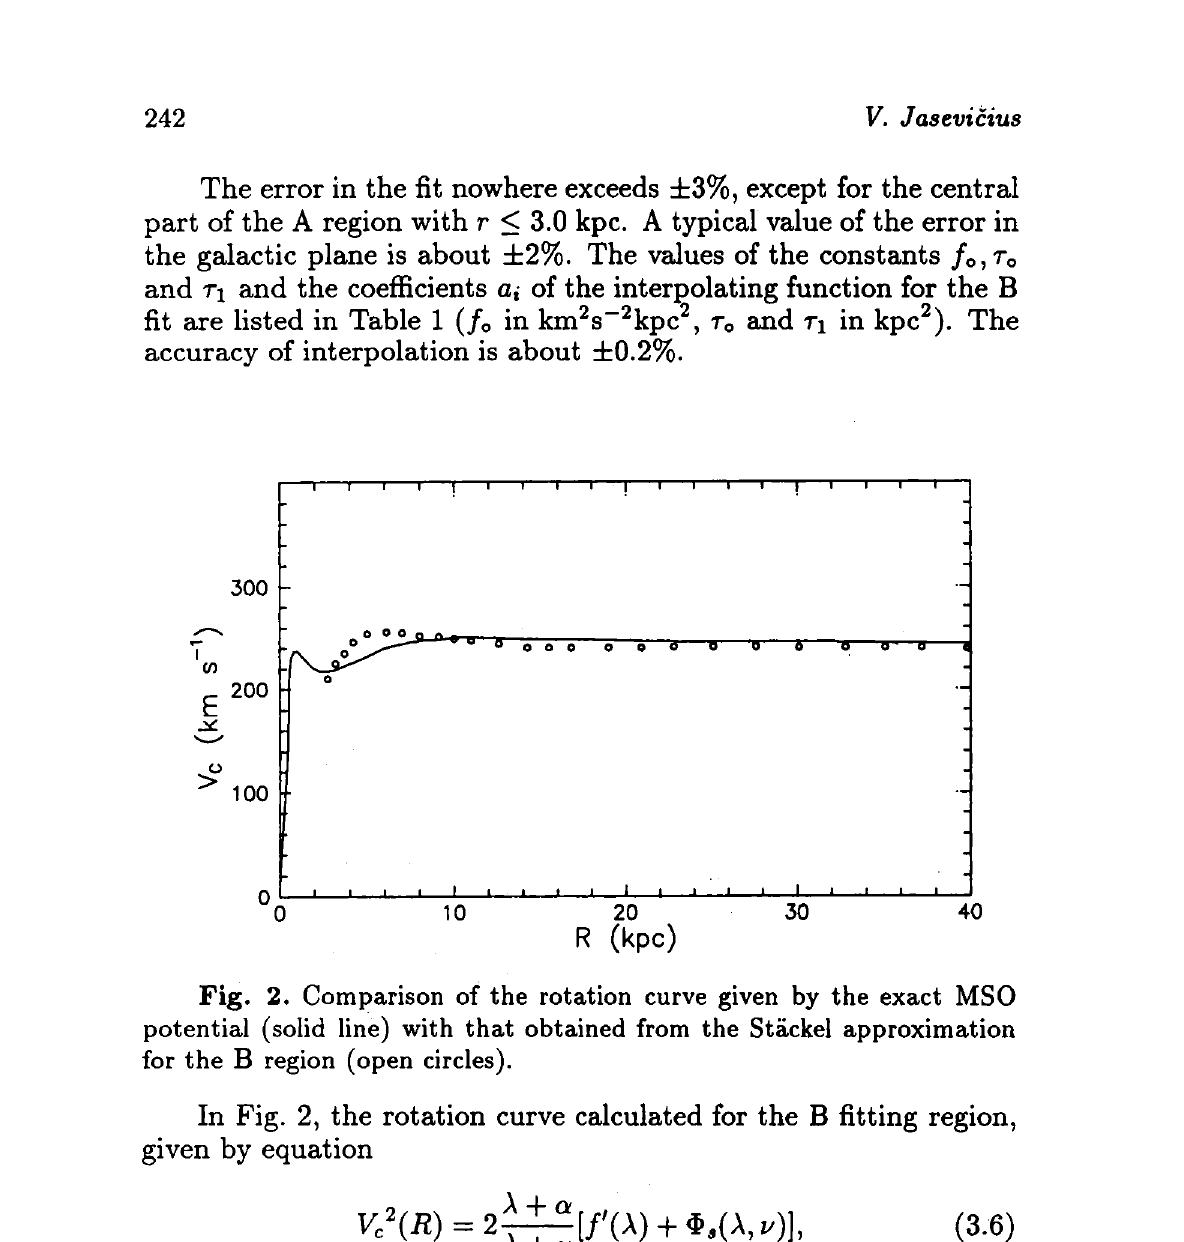
Fig. 2. Comparison of the rotation curve given by the exact MSO potential (solid line) with that obtained from the Stackel approximation for the B region (open